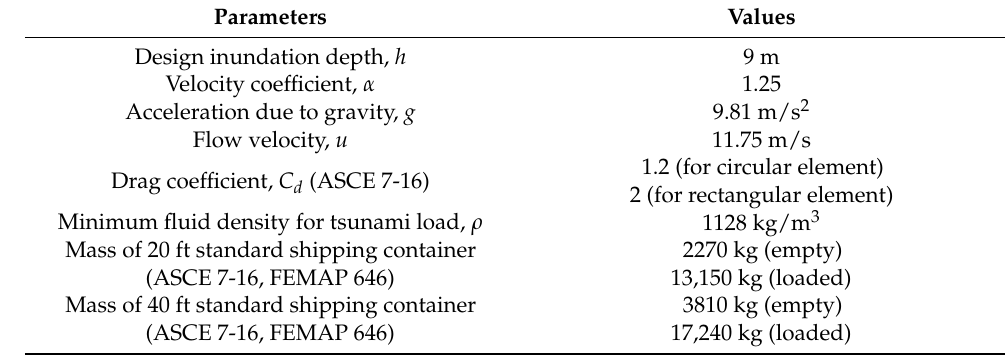
Table 3. Parameters of tsunami